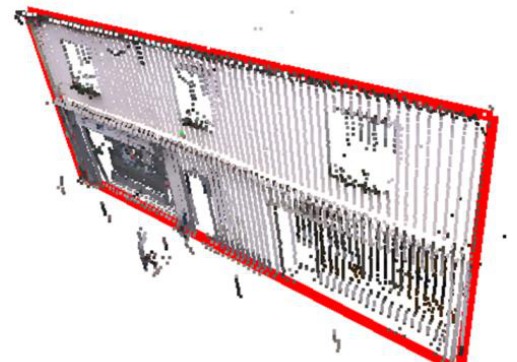
Figure 4: Plane and contour (red) approximated with the laser points